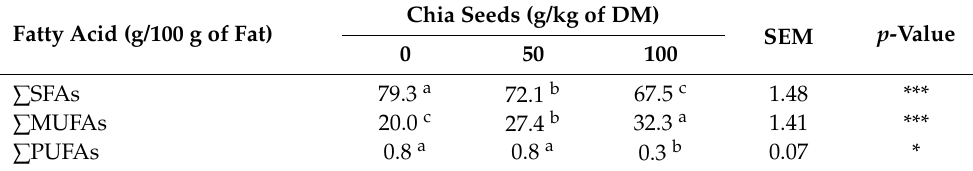
FAME means fatty acid methyl-esters, SEM means Standard Error of the Mean, n.s. means not significative, * = p < 0.01, ** = p < 0.001. *** = p < 0.0001. Means in the same row with different superscripts are